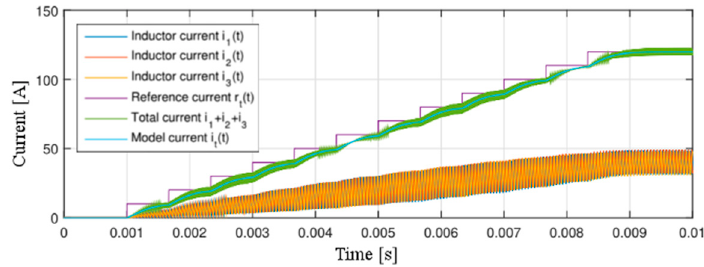
Figure 15. Total and inductor currents under reference current variation from 0 A to 120 A with 10 A steps.